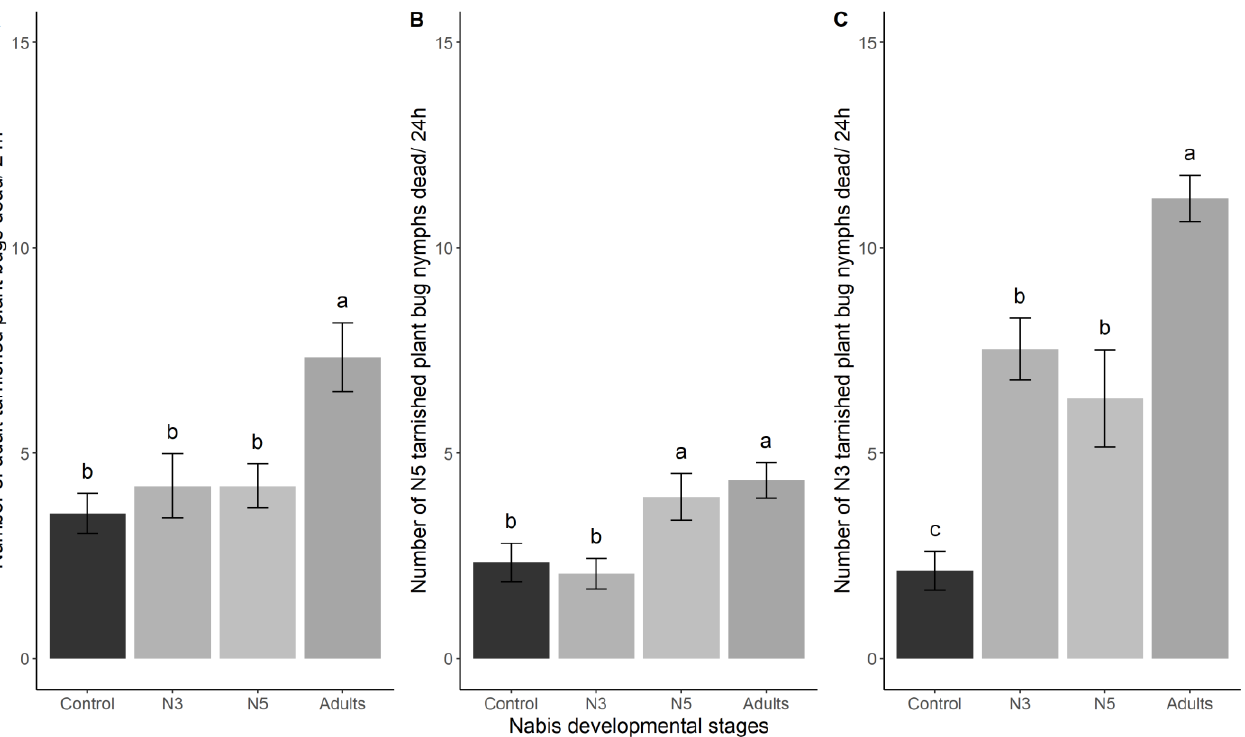
Figure 1. Mean mortality of TPB adults ( A ), N5 ( B ), or N3 ( C ) nymphs as a function of the Nabis americoferus developmental stage. Error bars represent standard errors. Letters correspond to significant differences among treatments (α = 0.05).